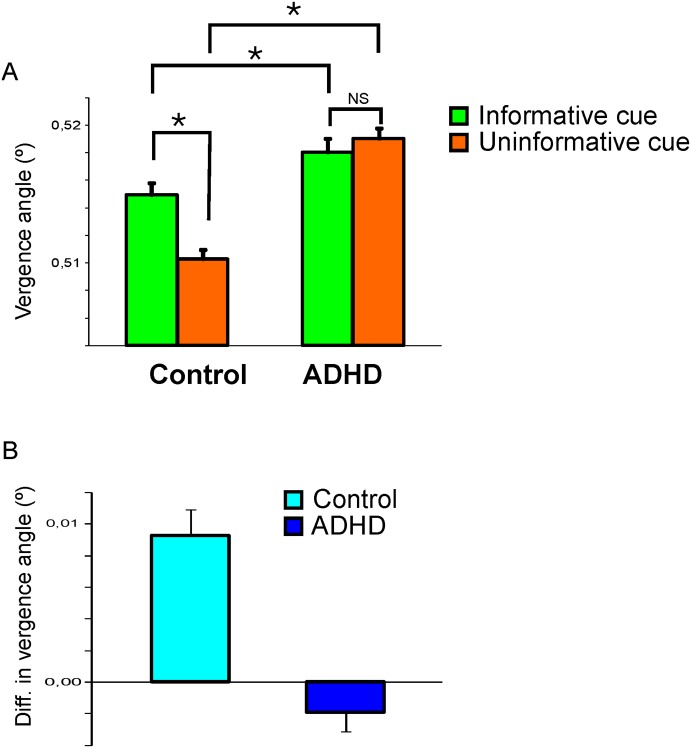
Mean sizes of angle of vergence for the different cue conditions (A) and the difference herein (B).Bars denote control/ADHD group. Error bars are SEM. Asterisks denote statistical significance. NS = not significant.